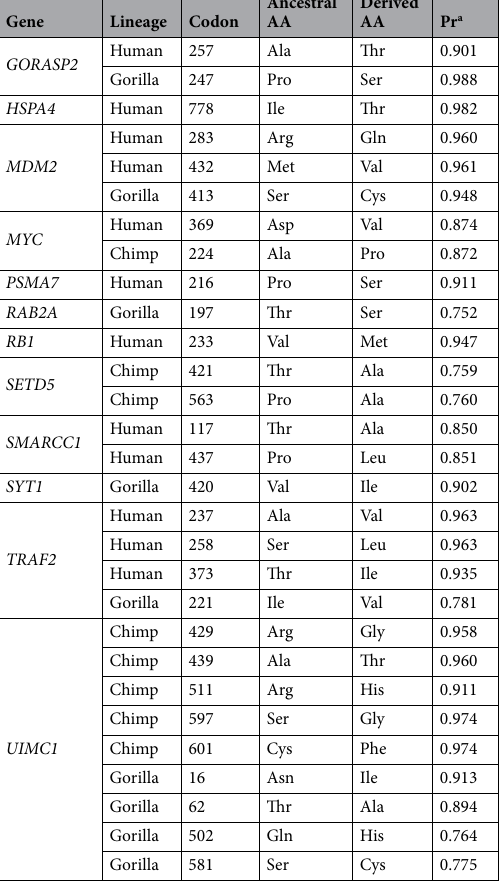
Table 3. Positively selected sites in the human, chimpanzee and gorilla lineages. a Posterior probability of γ ≥ 1 as detected by